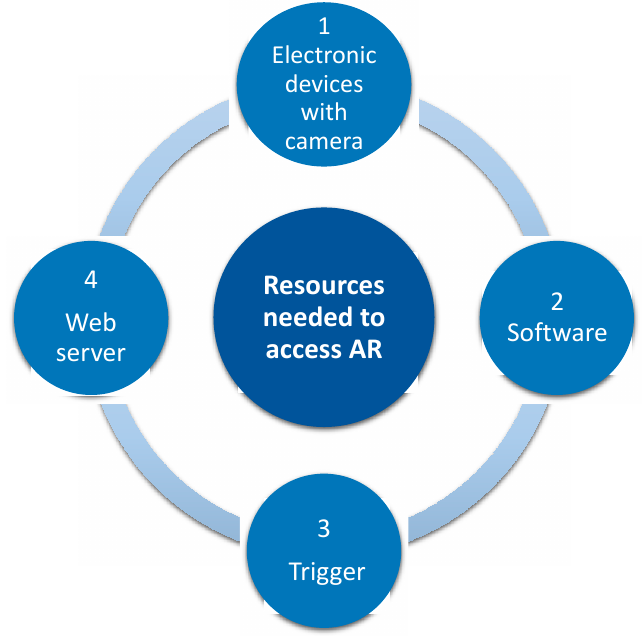
Figure 1. Resources needed to access AR. AR: augmented reality.